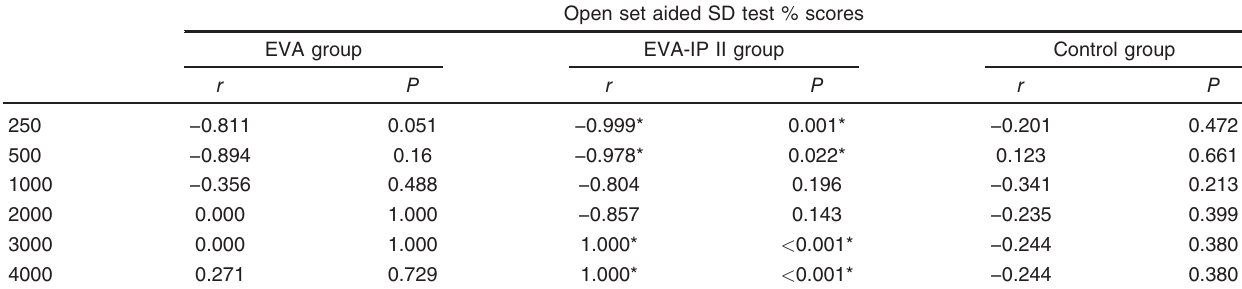
Table 6 Correlation between open-set speech discrimination test scores and preoperative aided thresholds in each group